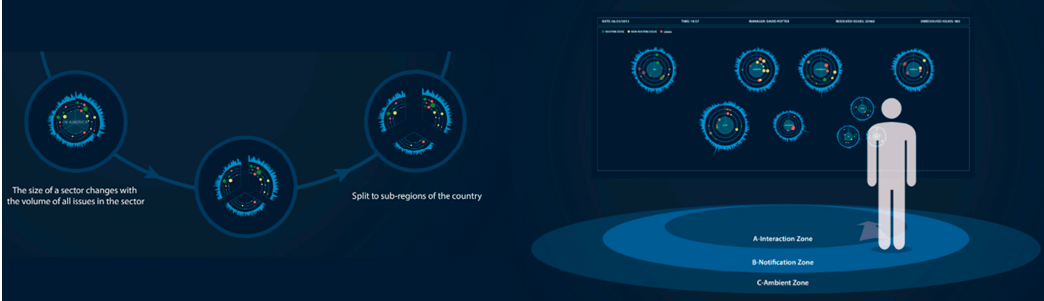
Figure 6. Physical movement and visualization transformation from the Ambient Zone to the Notification Zone.